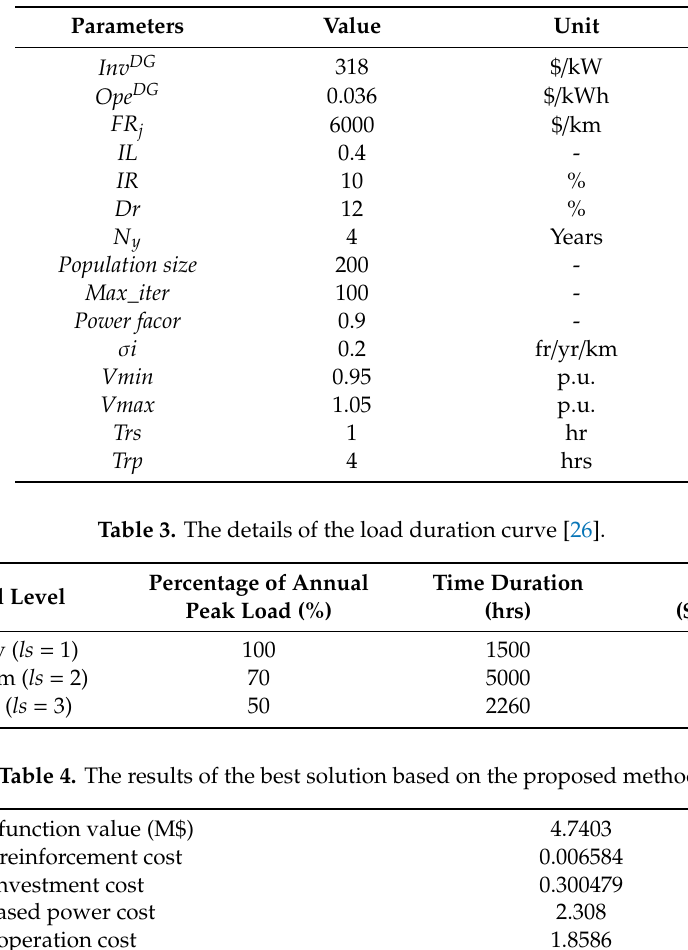
Table 2. The simulation data [26].